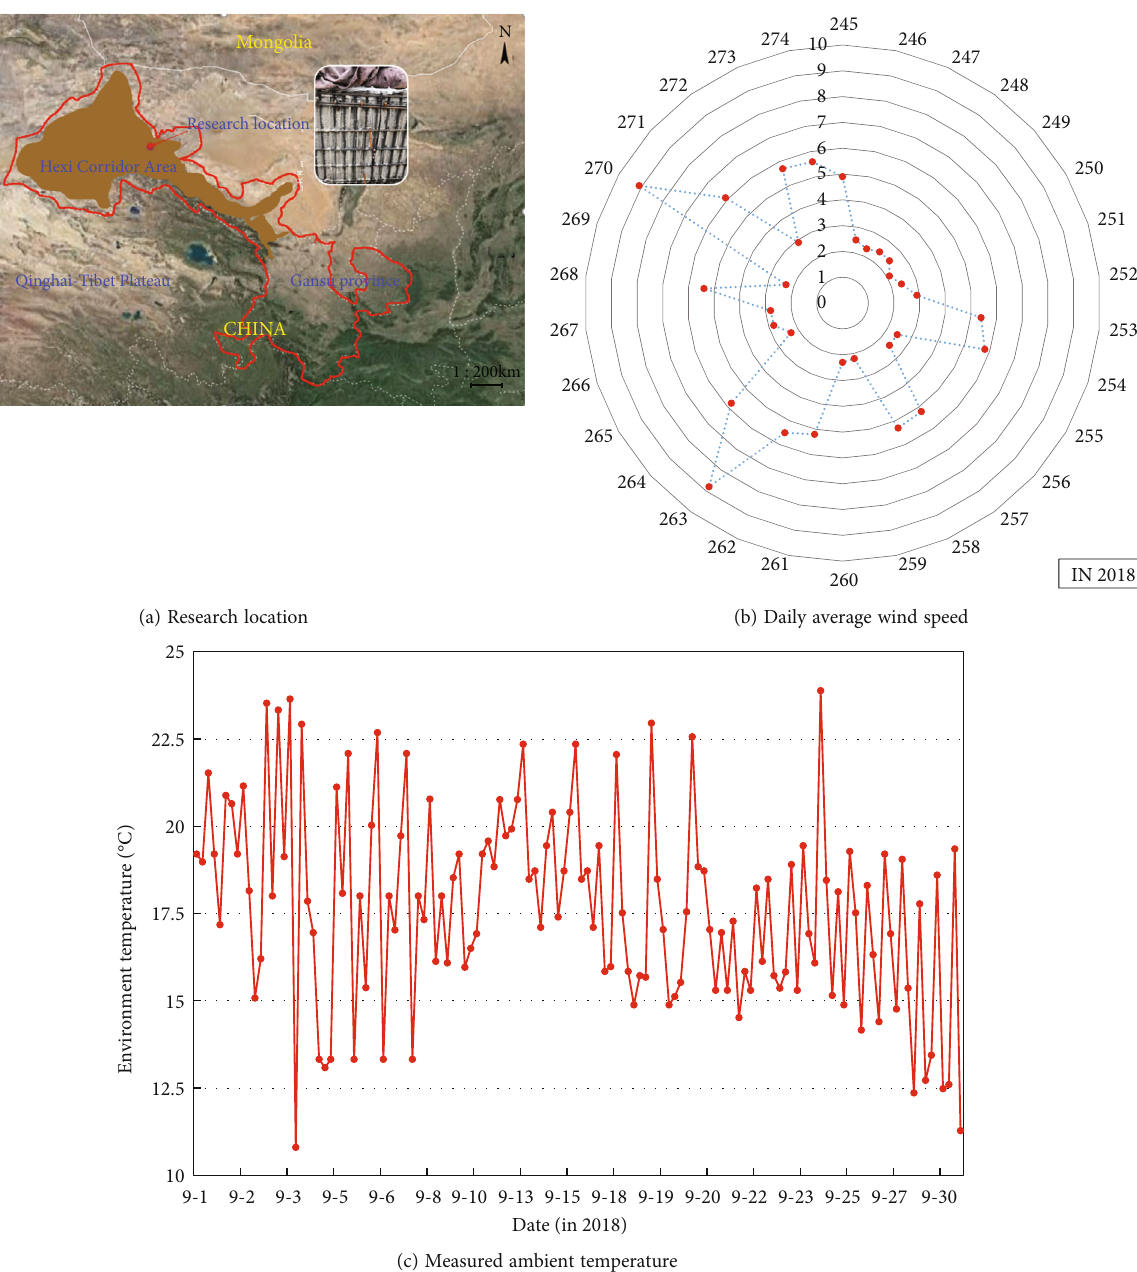
Figure 1: Research location and environmental